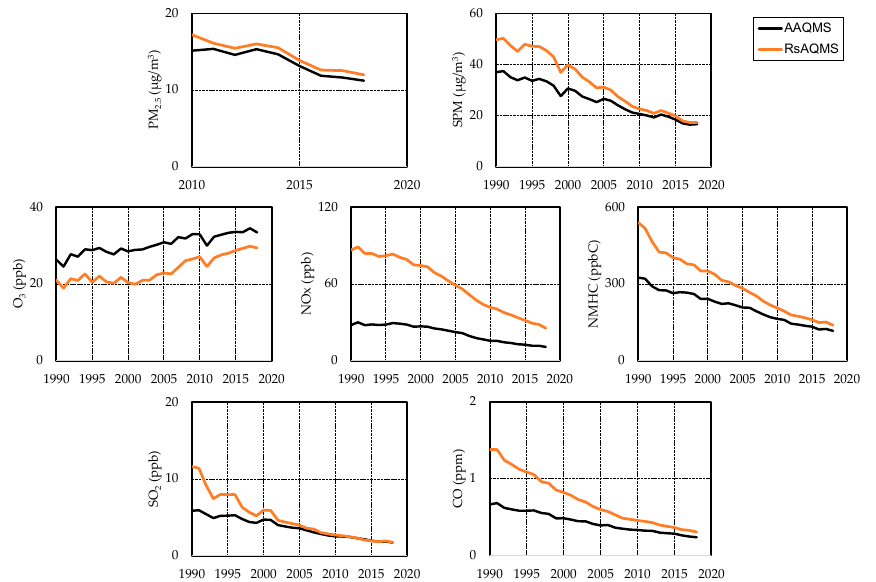
Figure 2. Annual average concentrations of air pollutants at AAQMS and RsAQMS in Japan from 1990 to 2018 (top: PM 2 . 5 and SPM, middle: O 3 , NOx and NMHC, bottom: SO 2 and CO).